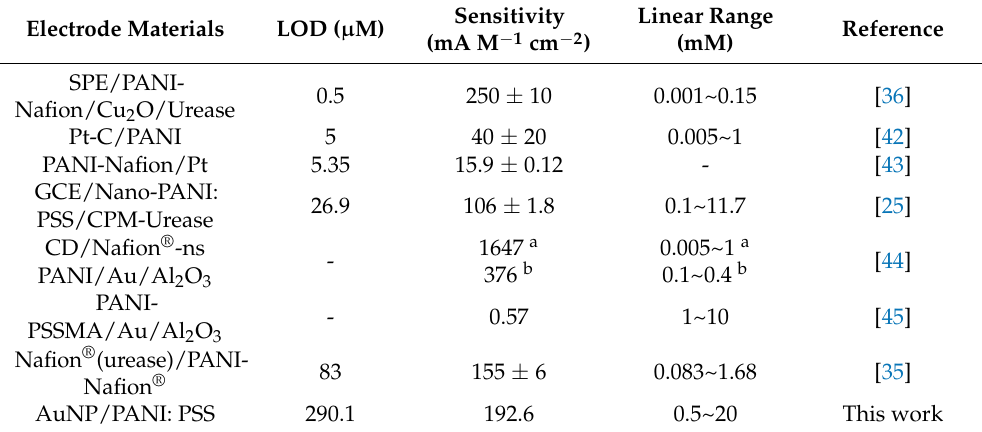
Table 1. Comparison of electrode properties for NH 4+